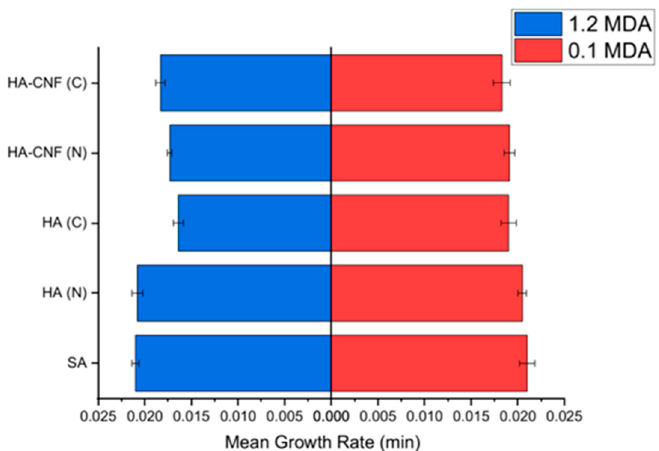
Figure 2. Different MW of HA and HA-CNF (carbon nanofibers) films showing antimicrobial activity against S. aureus . HA shows good antimicrobial activity, compared to crosslinked HA and to biocomposite. Reprinted from [11]. Copyright 2021, with permission from Elsevier.